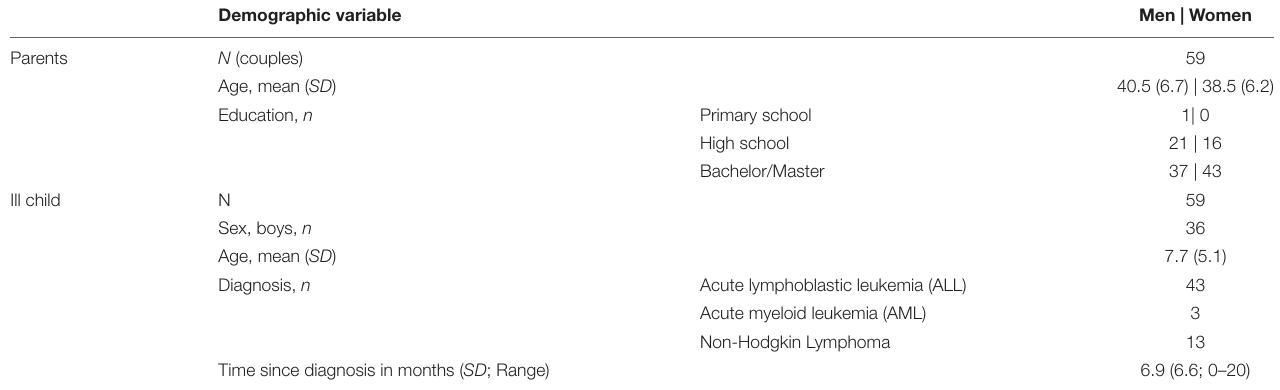
TABLE 1 | Background characteristics of couples of children with Leukemia or non-Hodgkin lymphoma.